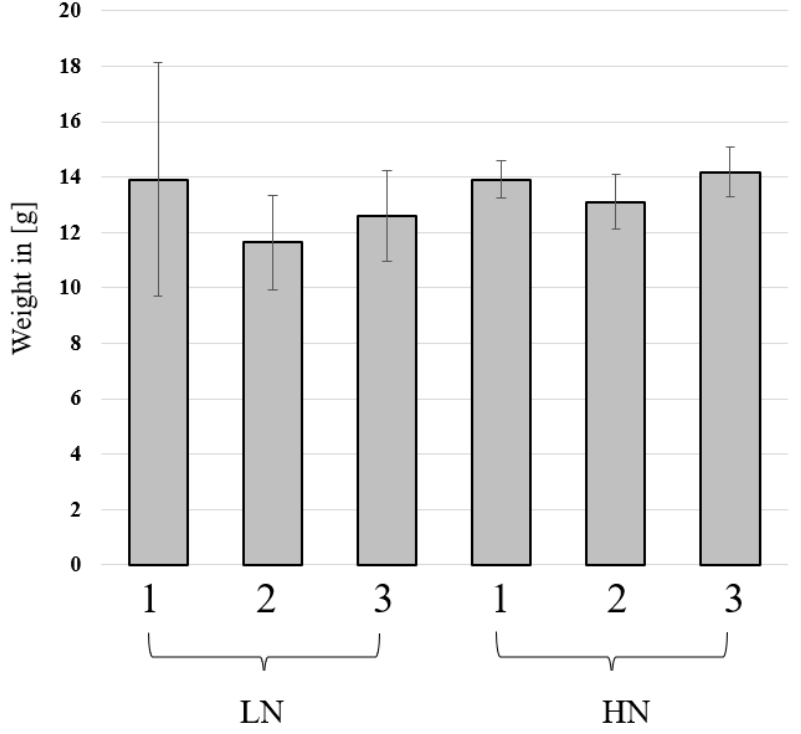
Figure 2. The dry yield of black soldier fly larvae (BSFL) grown on different fibre components and two nutrient levels. BSFL were grown in high-nutrient (HN) or low-nutrient (LN) substrates and with 3 fibre components (1: powder cellulose, 2: lignocellulose, or 3: ground straw). The larvae were harvested and dried, and the final dry yield was measured. The mean is shown with the standard deviations. Kruskal–Wallis test (n = 5, p < 0.05) revealed no effects on the dry yield.